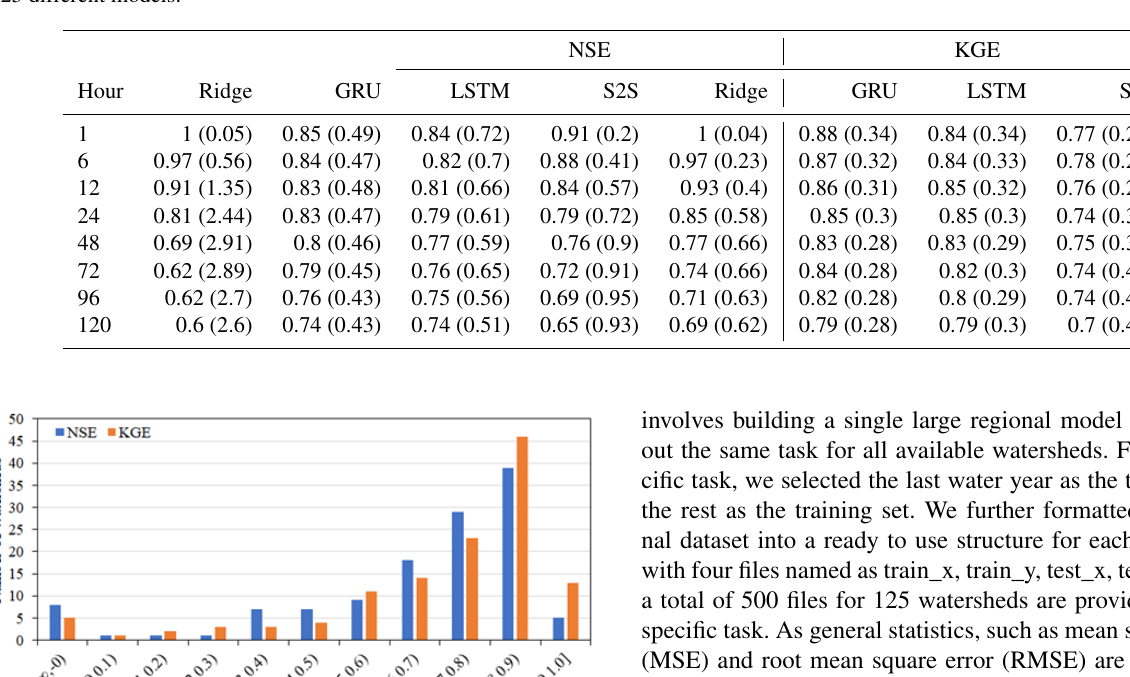
Figure 3. The median NSE and KGE among 125 watersheds in 125 different models at the prediction of the next 1–120h. Table 4. The median (standard deviation) NSE and KGE among 125 watersheds at the prediction hours 1, 6, 12, 24, 48, 72, 96, and 120 in 125 different models.